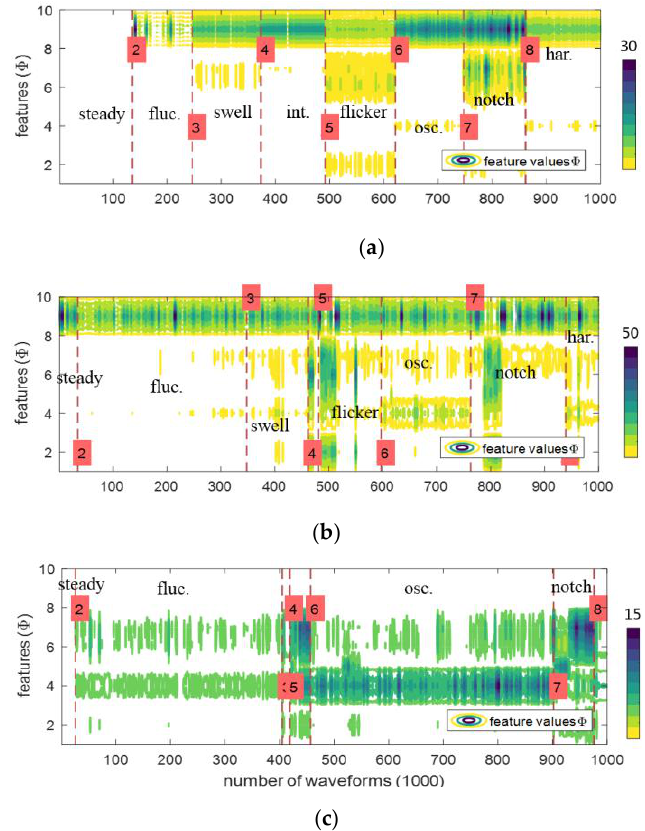
Figure 7. Feature value distributions of classified disturbance types and trigger conditions. ( a ) Model-generated waveforms; ( b ) Field obtained voltage waveforms and its classification; ( c ) Field obtained current waveforms and its classification.